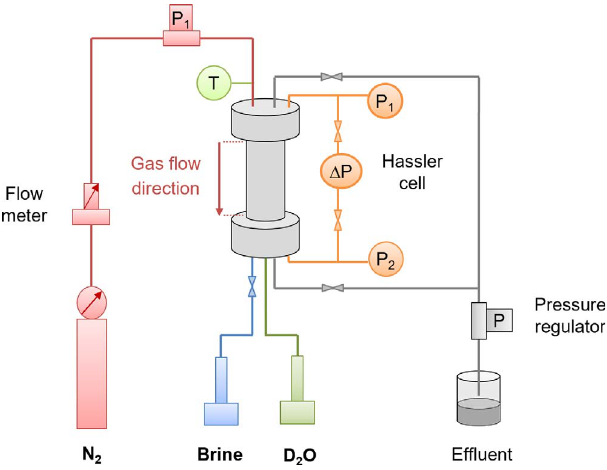
Fig. 2. Overview of the